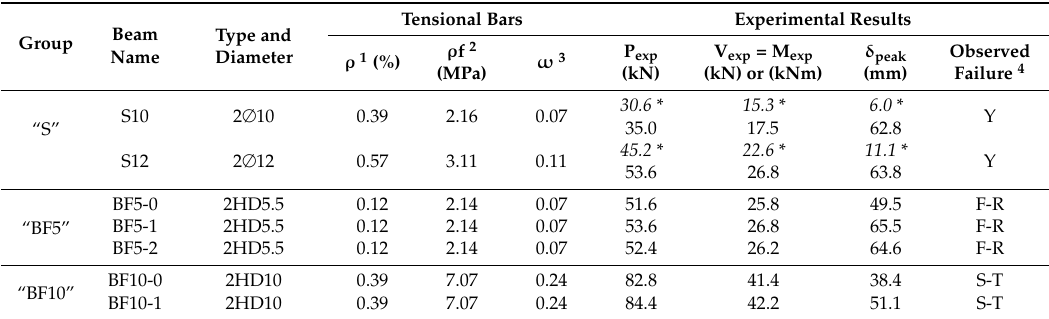
1 Geometrical reinforcement ratio: ρ 2 Geometrical reinforcement ratio s for the steel bars and ρ f for the C-FRP bars. × tensile strength: ρ s f y for the steel bars and ρ f f fu for the C-FRP bars. 3 Mechanical reinforcement ratio: ω s = ρ s f y /f c for the steel bars and ω f = ρ f f fu /f c for the C-FRP bars. 4 Failure mode notation: Y: Typical flexural failure after steel Yielding with adequate ductility; F-R: Flexural failure due to the rupture of the carbon fibers of the C-FRP bars; S-T: Shear failure due to the diagonal Tension cracking. * Test results at steel